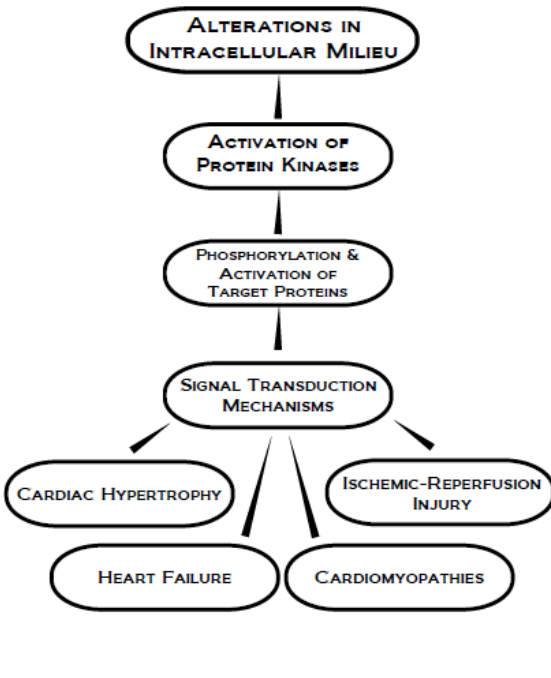
Figure 2. Schematic representation of protein kinase activation in signal transduction for the development of different types of heart